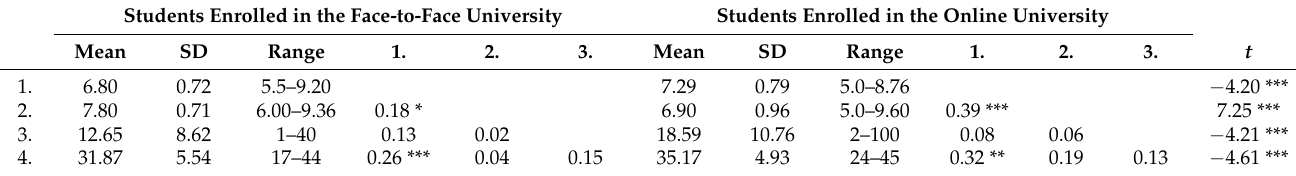
Table 1. Descriptive statistics, bivariate correlations, and t-test